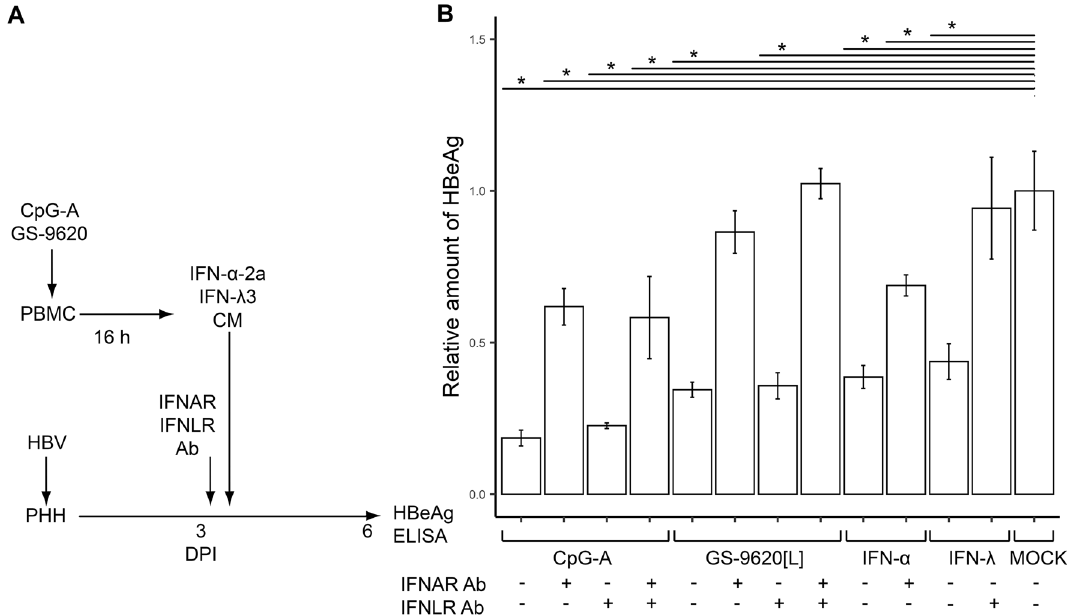
Figure 5. IFNAR mAb abrogates inhibition of HBeAg production from HBV-infected PHH by CpG-A-CM or GS-9620[L]-CM. ( A ) Experimental flow chart. HBV-infected PHH were exposed at 3 DPI to 5 µg/ml of IFNAR mAb, IFNLR mAb or control isotype mAb. Recombinant IFN-α-2a or IFN-λ3 (1,000 IU/ml) was used as a control. Production of HBeAg was determined by ELISA 6 DPI. ( B ) Production of HBeAg was normalized to production by HBV-infected PHH treated with CM from unstimulated PBMCs determined by ELISA 6 DPI. The data are shown as mean ± SEM from three independent experiments with PHH from one donor (N = 1). * p < 0.05, Mann–Whitney–Wilcoxon pairwise test, p value adjusted by BH